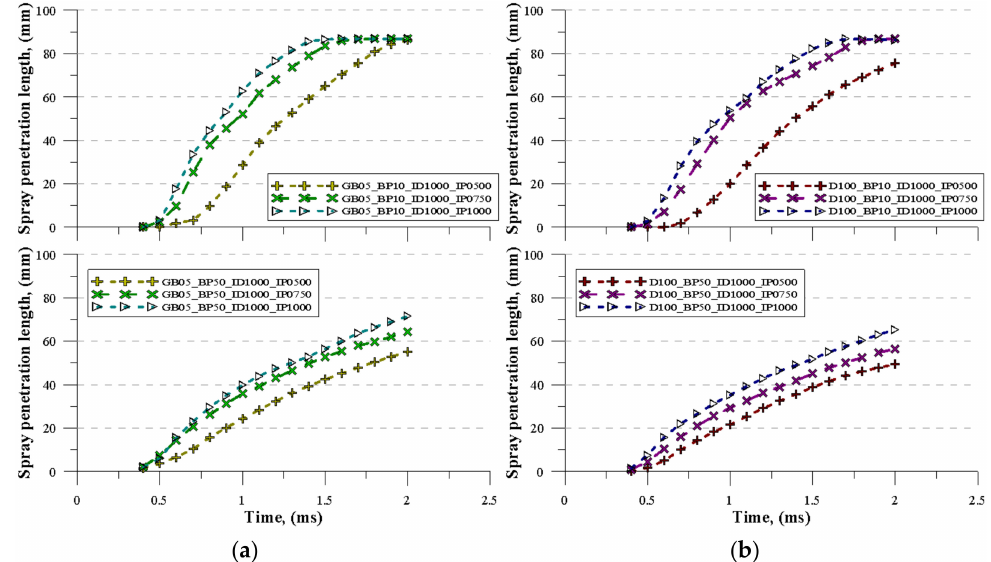
Figure 6. Spray penetrations of ( a ) GB05, and ( b ) D100 with injection duration 1000 µ s at back pressures of 10 and 50 bar and injection pressures of 500, 750 and 1000